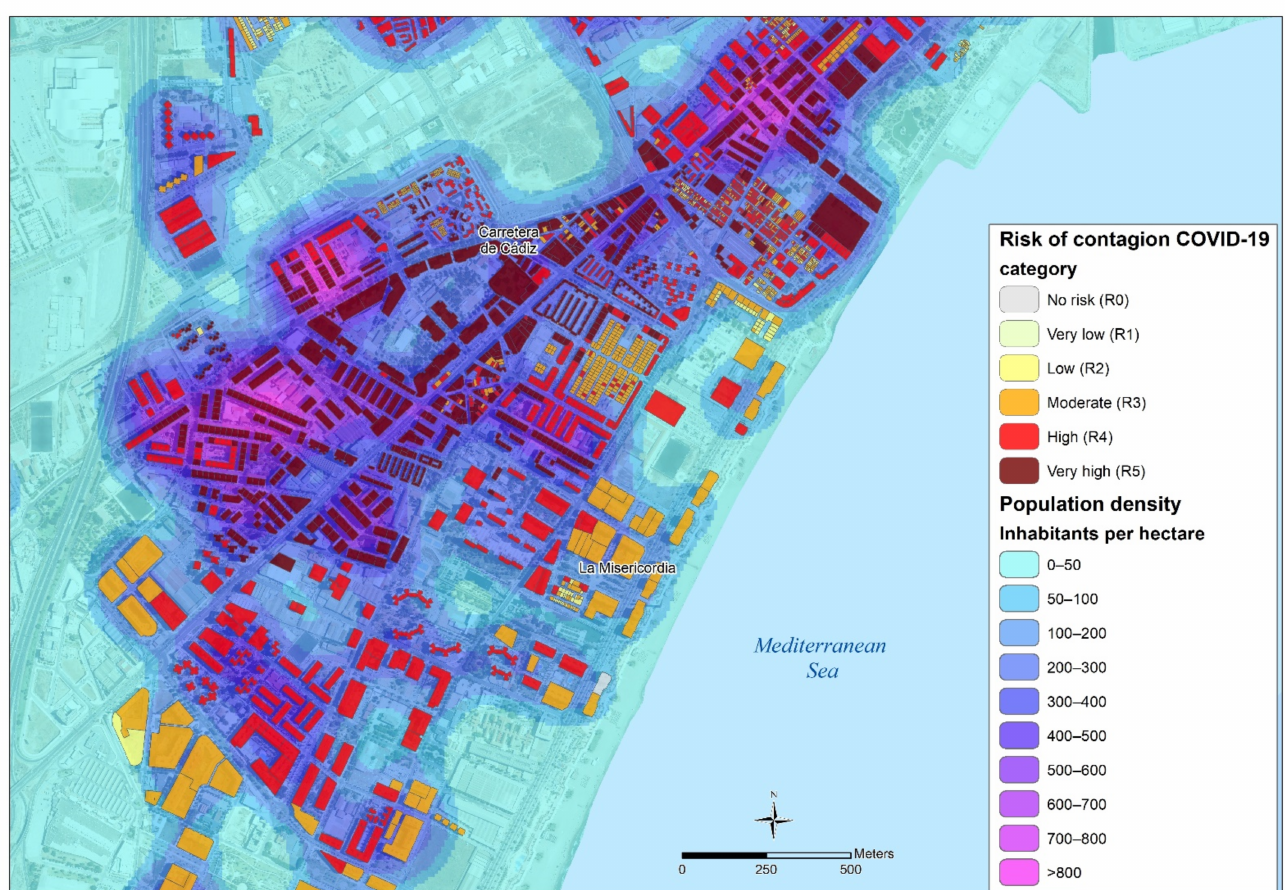
Figure 14. Comparison of the population density and the risk of contagion in M á laga. Own